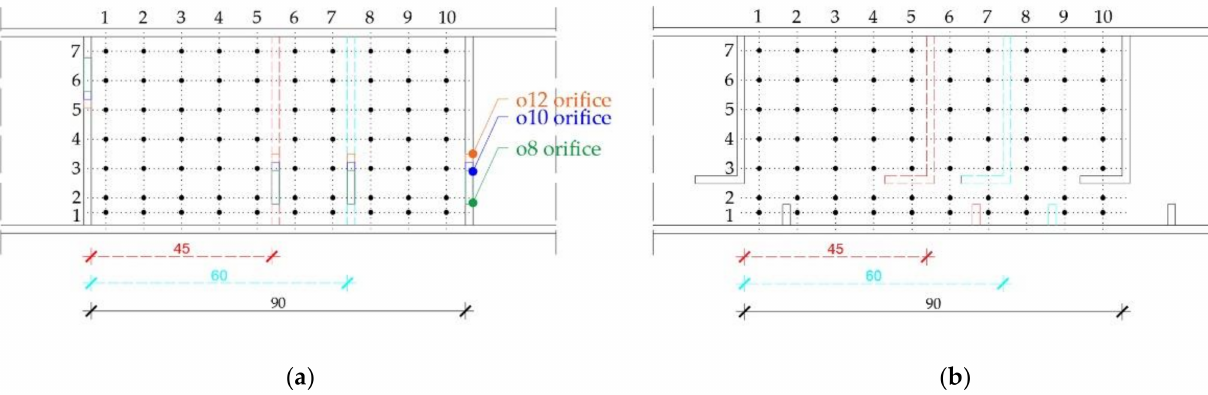
Figure 4. Structured raster of the measurement points in ( a ) pool-orifice fishway, ( b ) vertical slot